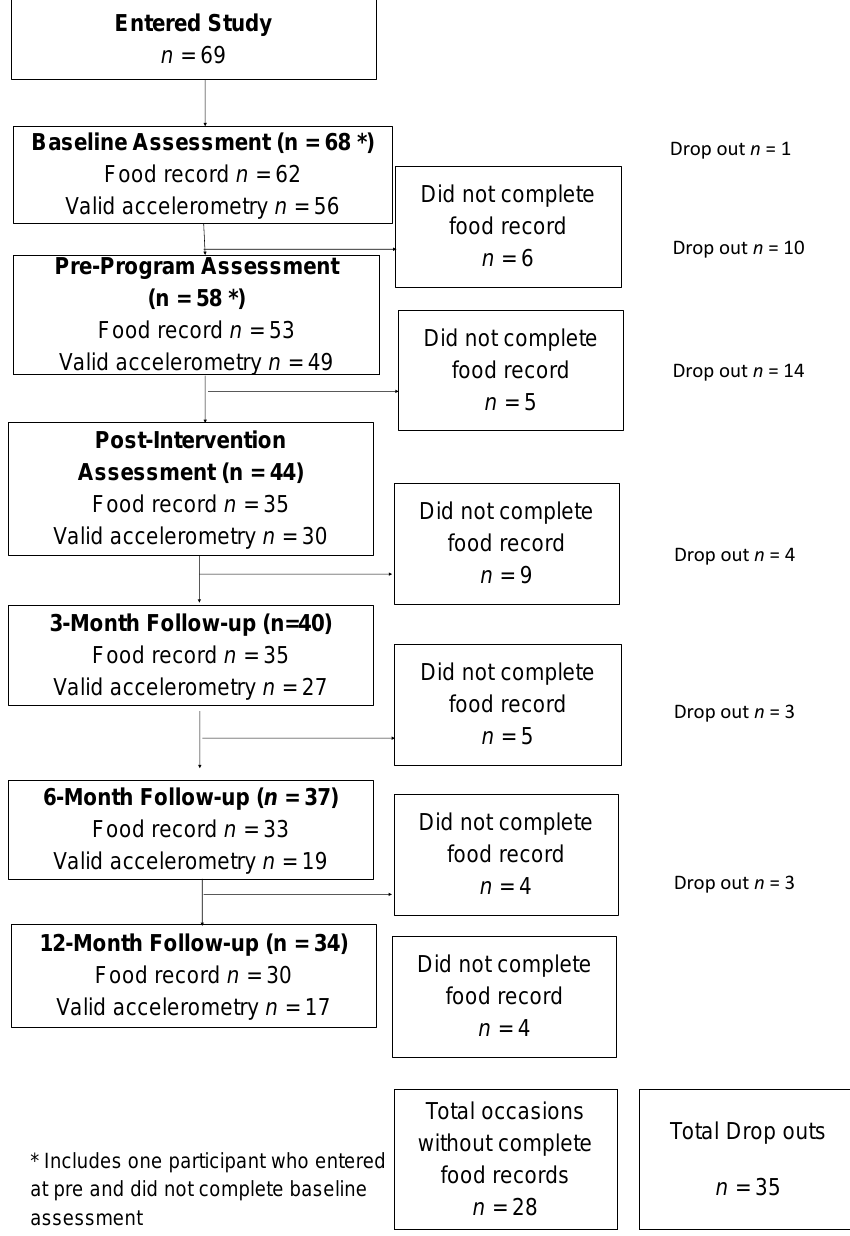
Figure 1. Participant numbers and food record completion during the waitlist controlled trial of Curtin University’s Activity, Food, and Attitudes